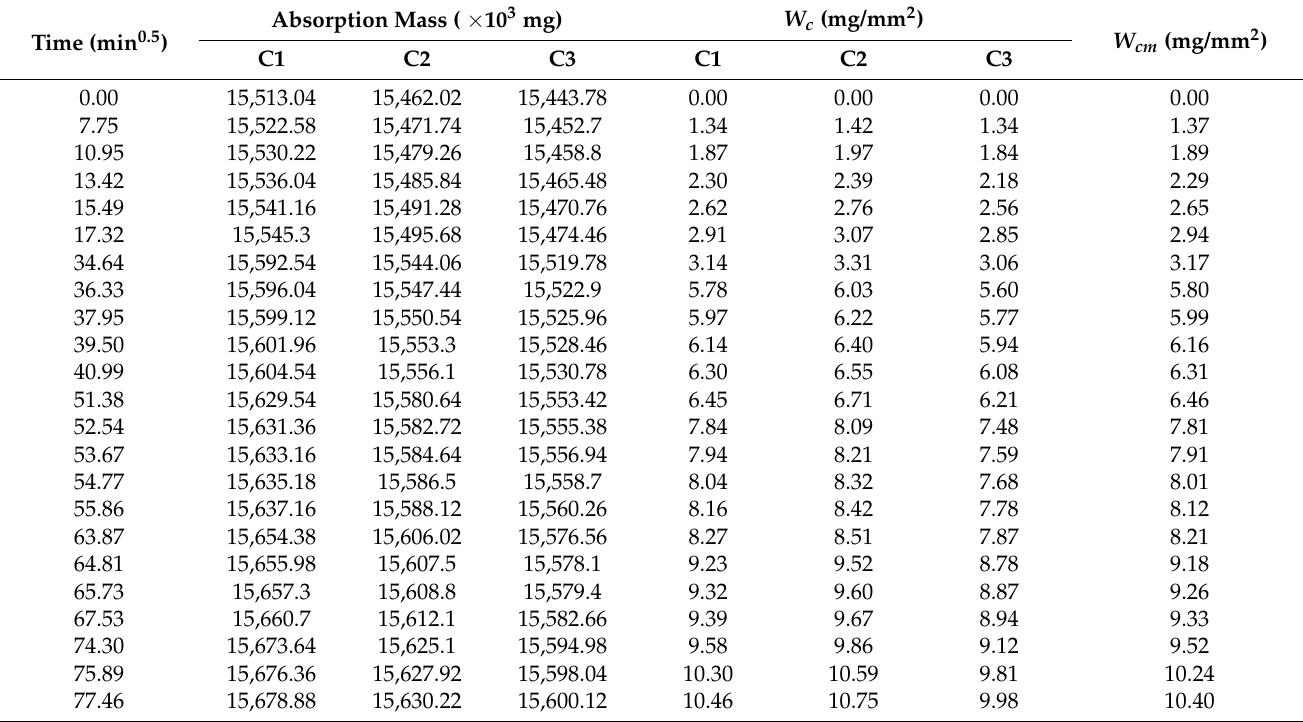
Table 15. Results of water absorption tests by capillarity for the FRC_EAFS mixture.